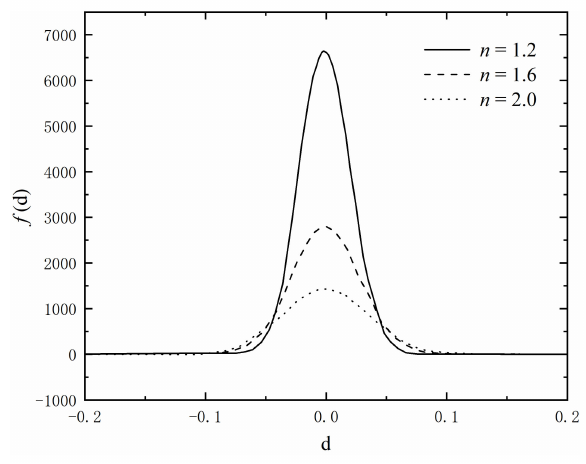
Figure 4. Gaussian distribution function curves with different n .